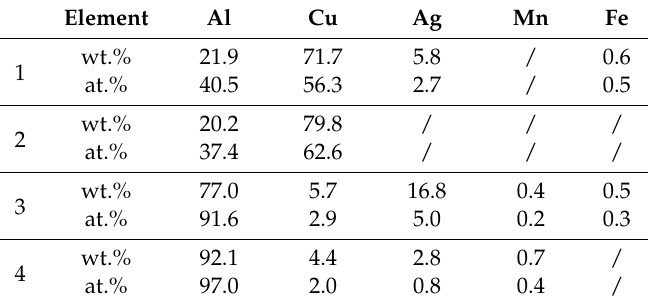
Table 2. EDS analysis of the chemical composition of the precipitation in positions marked out in Figure 4.